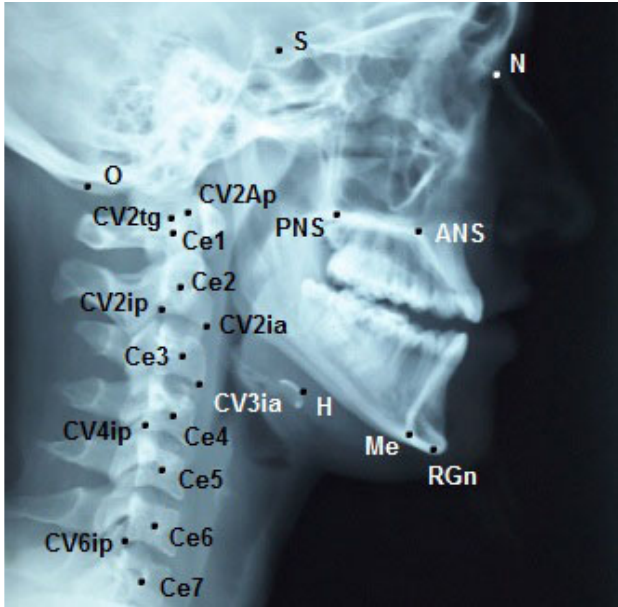
Fig. 1 - Anatomical points used in the cephalometric analysis: ANS – anterior nasal spine; PNS– posterior nasal spine; N (nasion) –anterior point at fronto-nasal suture; S (Sella) – center of sella turcica; H – most anterosuperior point of the Hyoid bone; O – basi-occiput; RGn (retrognathion) – the most inferior posterior point at the mandibular symphysis; Me (Mentum) – most inferior point at the mandibular symphysis; CV2tg - the tangent point at the superior posterior extremity of the odontoid process of the second cervical vertebra (C2); CV2ip - the most infero- posterior point on the body of the second cervical vertebra; CV2Ap – tangent point to the apex of the C2 dente;; CV2ia - the most infero-anterior point on the body of the second cervical vertebra; CV3ai – the most anterior inferior point on the body of the third vertebra; CV4ip - the most infero-posterior point on the body of the fourth cervical vertebra; CV6ip - the most infero-posterior point on the sixth cervical vertebra; Ce1 a Ce7 – central points of the vertebral bodies from C1 to C7. Chart 1 – Lines and angles of the cephalometric analyisis of the cranicocervical posture and the mandibular